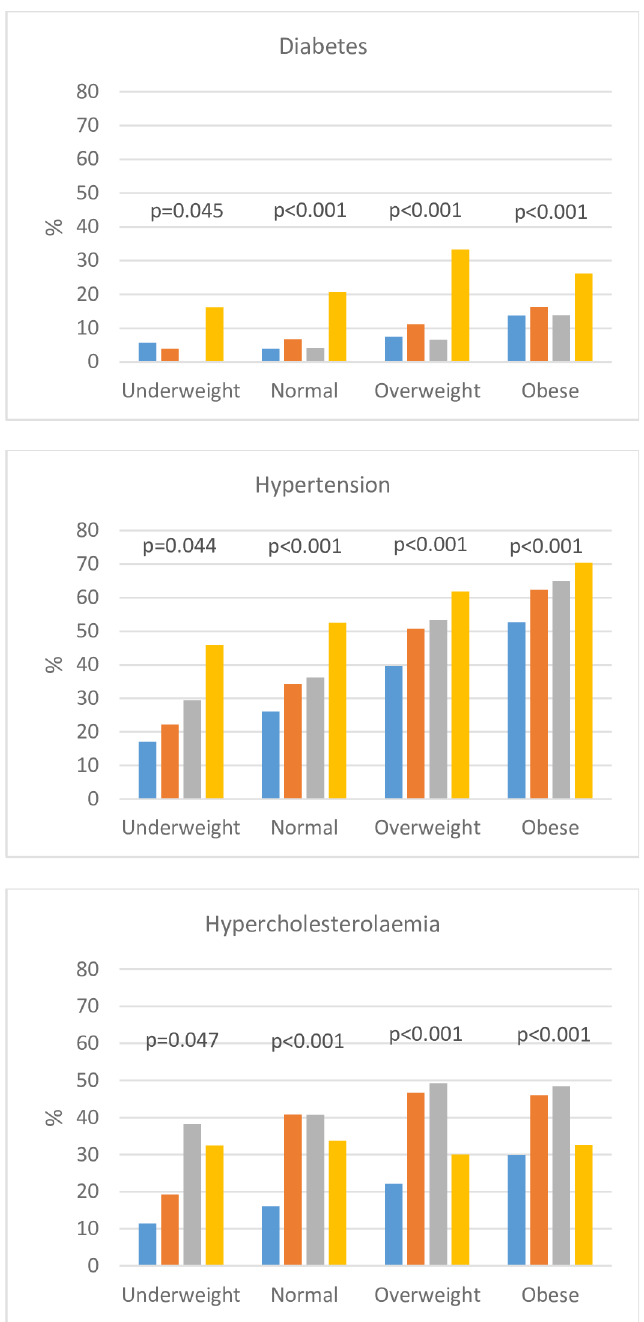
Fig 1. Prevalence of cardio-metabolic diseases by BMI category and population group. Black is designated by a blue square. Coloured is designated by an orange square. White is designated by a grey square. Indian is designated by a yellow